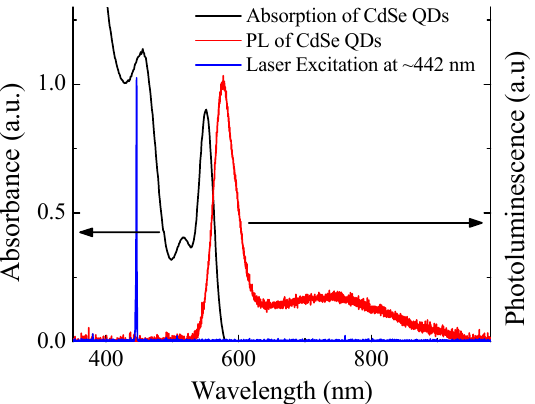
Figure 1. Absorption and photoluminescence spectra of CdSe QDs. The PL peak observed at 576 nm originates from the band edge transition while the long tail spanning from 625 nm to 950 nm is due to the surface-trapped state transition. synthesis/growth processes. The PL from the surface-trapped state is attributed to carrier recombination at the defect sites, while the band edge transition is related to recombination closer to the bandgap. It is clear from the figure that the band edge transition domi- nates the PL spectra with 5-fold PL intensity compared to that of the surface-trapped state at room temperature. Figure 2 shows temperature dependent photoluminescence of CdSe QDs measured from 6 K to 300 K. The temperature dependent band edge transition at 568 nm at 6 K to 575 nm at 300 K was observed for increasing temperature in correspondence with the literature [25].